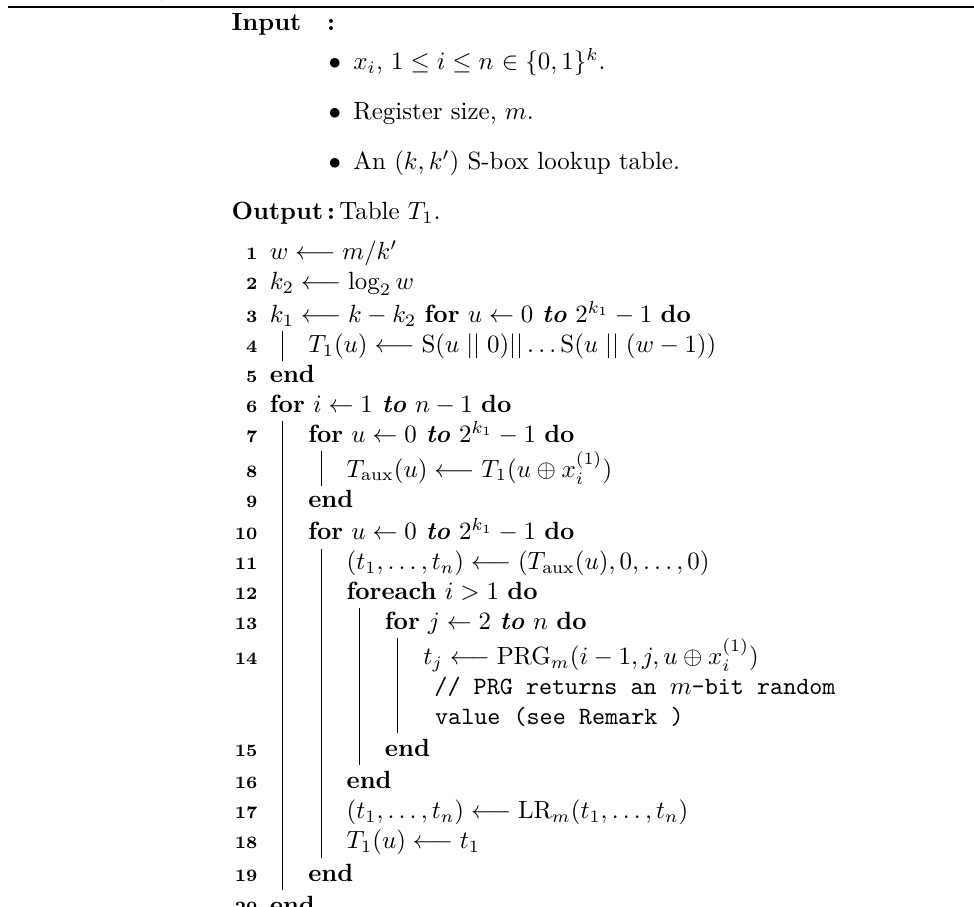
Algorithm 9: Construction of T 1 for larger register variant using robust